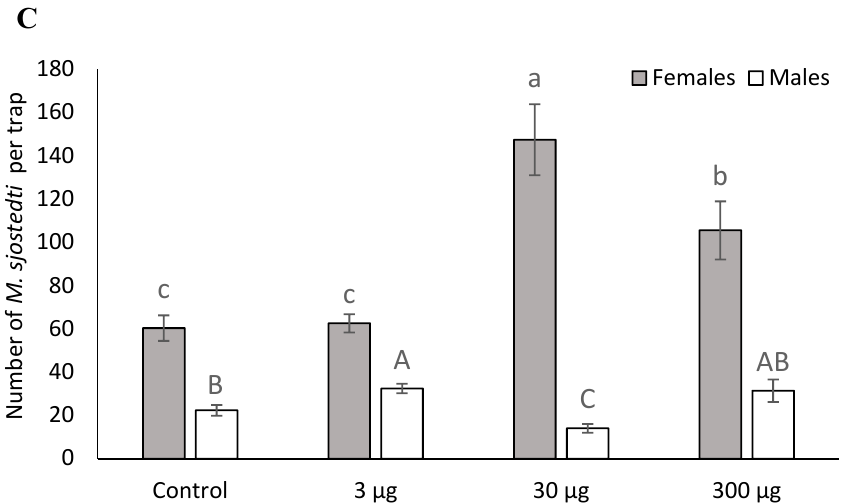
Figure 3. Effect of different doses of major compound on trap catch of female and male M. sjostedti during field experiments in September 2018 ( A ), January 2019 ( B ), and February 2019 ( C ) at Mbita, western Kenya. Means bearing the same uppercase or lowercase letters are not significantly different by Tukey HSD test at 95% confidence.